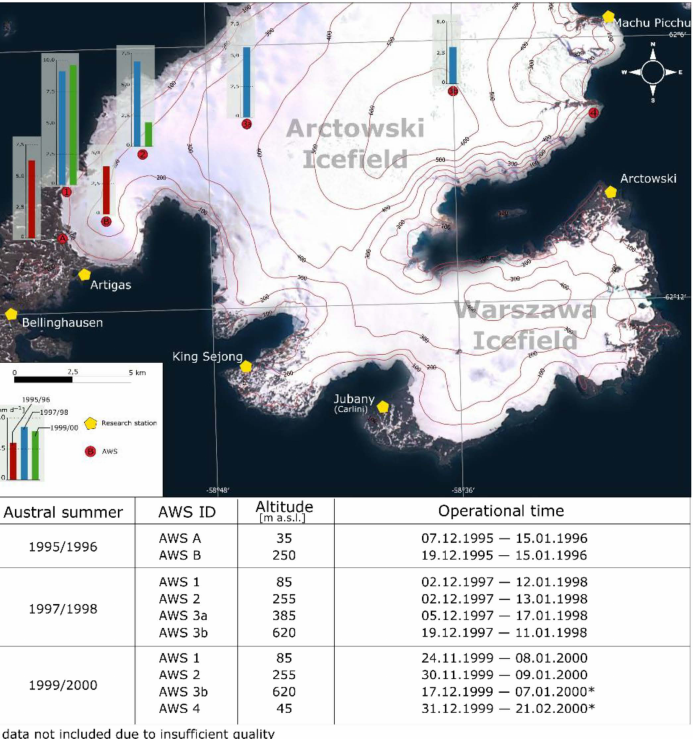
Figure 3. Locations and operation times of the AWSs on KGI during the different field campaigns and the corresponding ablation rates. Modified with permission from Braun et al. [34] published by ProAntar,